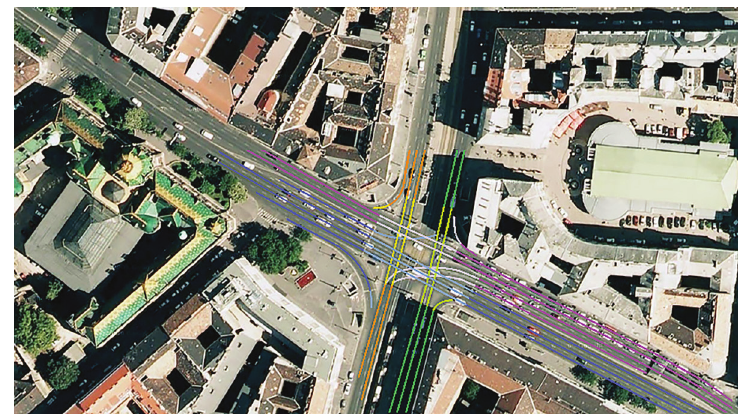
Fig. 5. Üllői Road, one radial main road of Budapest (source: own